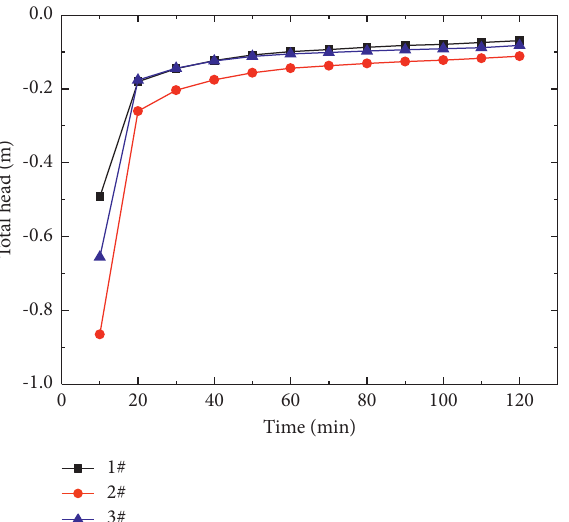
Figure 18: Total head at observation points 1–3 of building 1 without seepage wells around buildings in the numerical